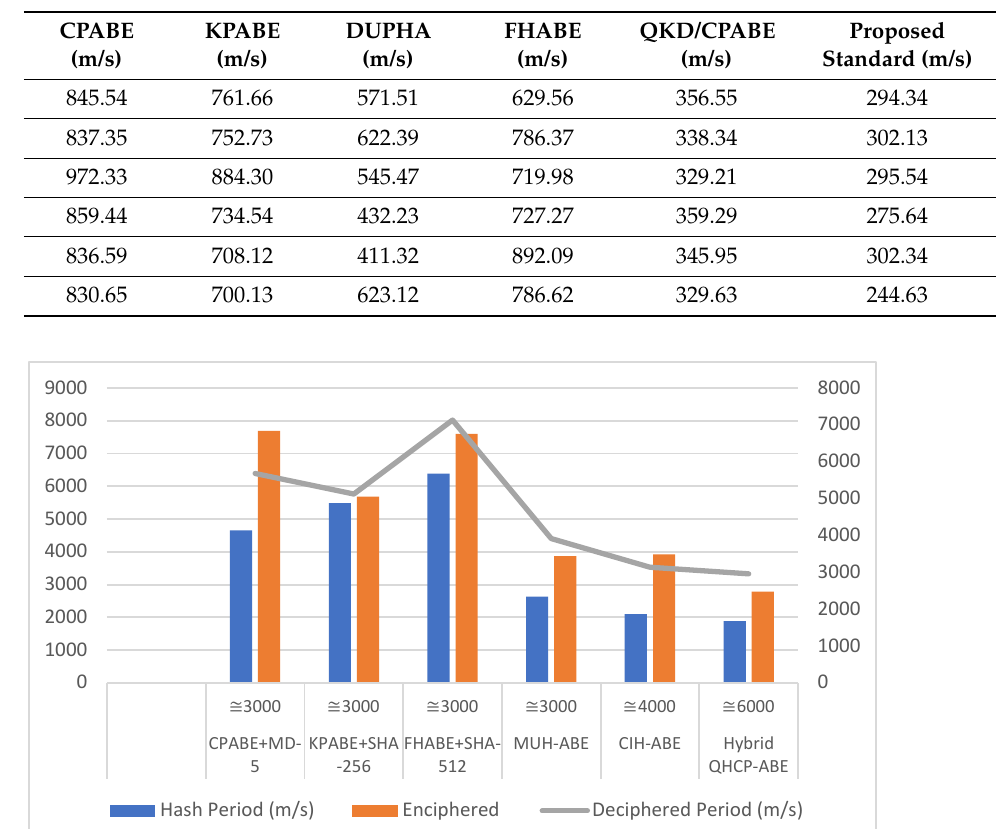
Table 3. Relative investigational findings of planned reliable hybrid quantum CPABE over the conventional enciphered standards w.r.t execution time as parameter.